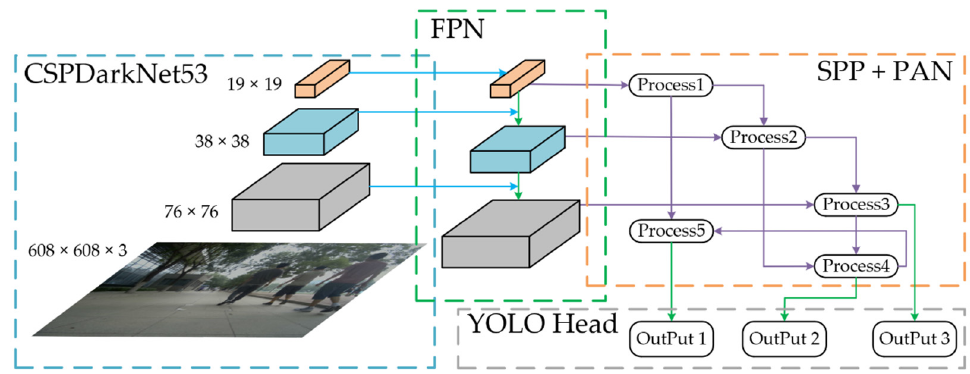
Figure 2. Structure of pedestrian detection based on YOLO V4.